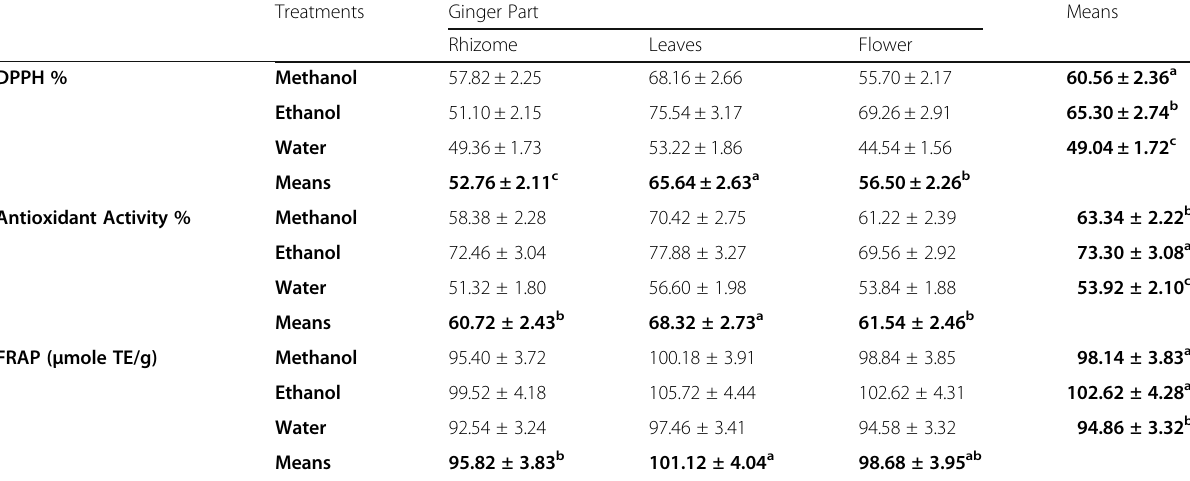
Table 3 Means for DPPH, Antioxidant activity and FRAP assay of ginger extract